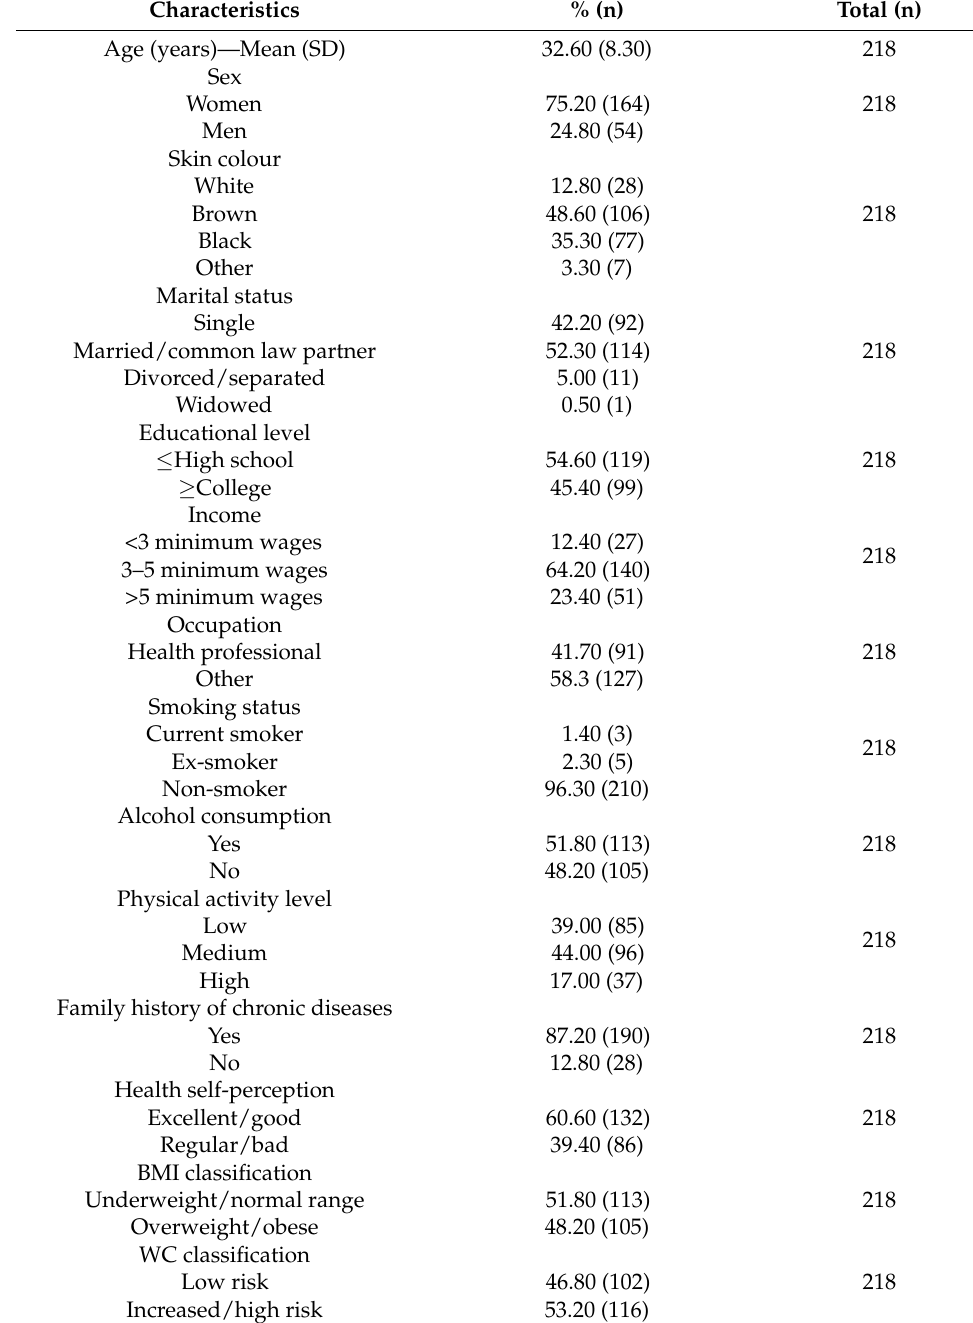
Table 1. Descriptive analysis of the workers characteristics at baseline, Santo Ant ô nio de Jesus city,